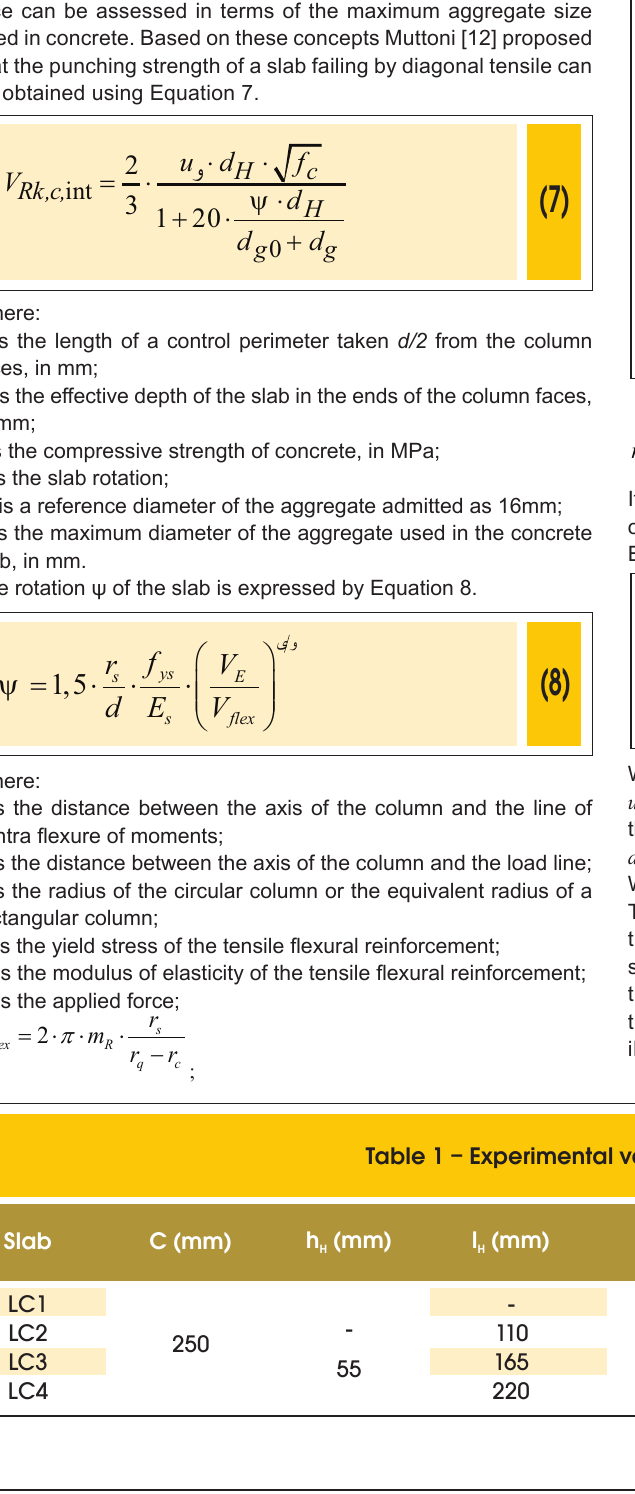
Figure 7 – Graphic representation of the punching strength determination according to